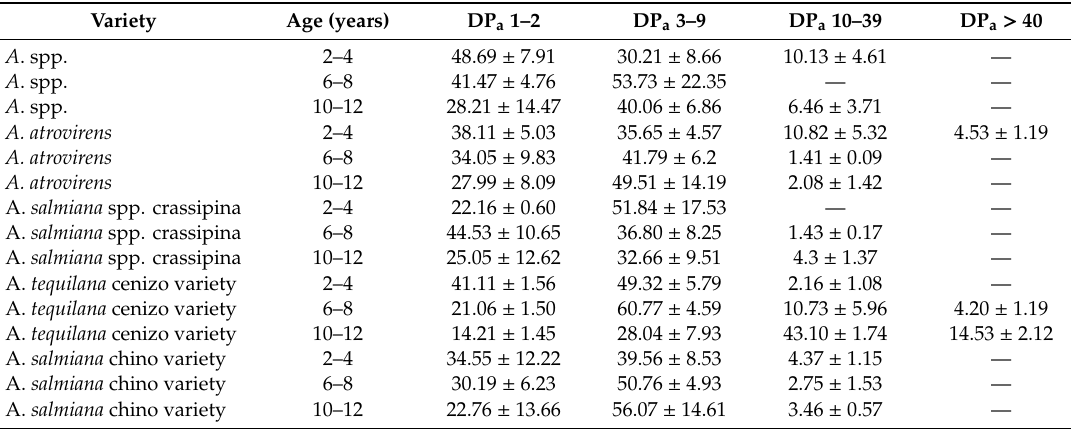
Table 2. Relative area value of the degree of polymerization of agave